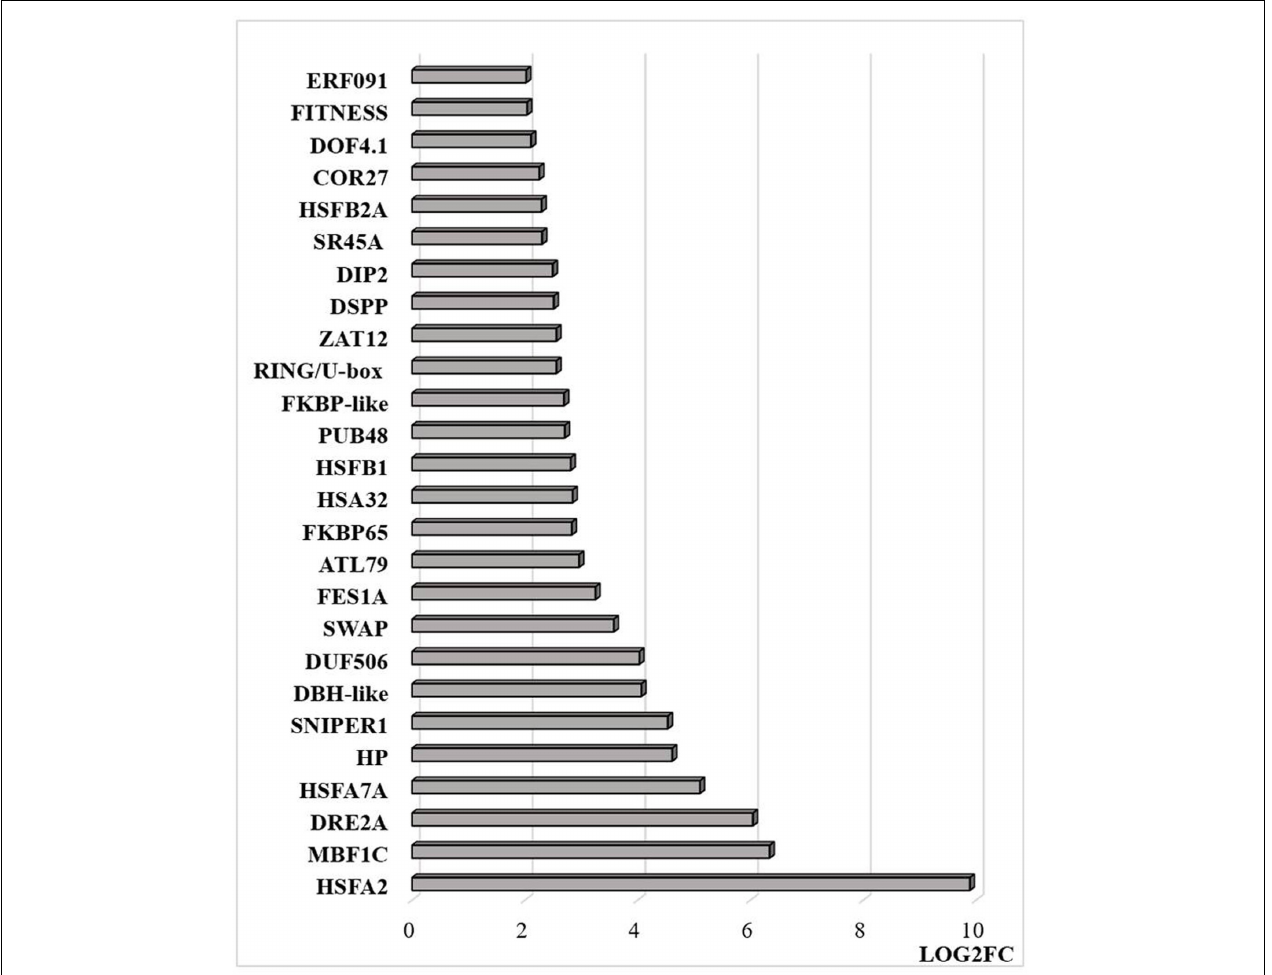
FIGURE 9 | Transcripts that are differentially regulated by heat stress and targeted to the nucleus. The abundance is expressed as relative expression of (log2) fold change (LOG2FC) with an FPKM > 1 and FDR-corrected p- value of 0.05 or less. The thresholds were (LOG2FC > 2) and (LOG2FC < − 2) for up- and down-regulated genes, respectively. HSFA2 (AT2G26150), MBF1C (AT4G25490), DRE2A (AT5G05410), HSFA7A (AT3G51910), HP—hypothetical protein (At1g21550), SNIPER1 (AT1G14200), DBH-like (AT5G35320), DUF506 (AT3G25240), SWAP (AT3G49130), FES1A (AT3G09350), ATL79 (AT5G47610), FKBP65 (AT5G48570), HSA32 (AT4G21320), HSFB1 (AT4G36990), PUB48(AT5G18340), FKBP-like (AT5G03990), RING/U-box (AT5G05530), ZAT12 (AT5G59820), DSPP (AT1G07330), DIP2 (AT5G03210), SR45A (AT1G07350), HSFB2A (AT5G62020), COR27 (AT5G42900), DOF4.1 (AT4G00940), FITNESS (AT1G07050), ERF091